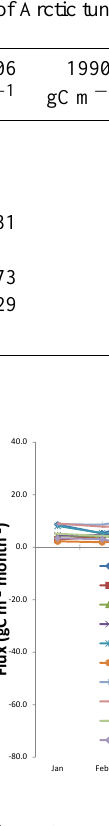
Fig. 7. Comparison among inversion model estimates of the mean net monthly exchange of CO 2 between Arctic tundra and the atmo- sphere.